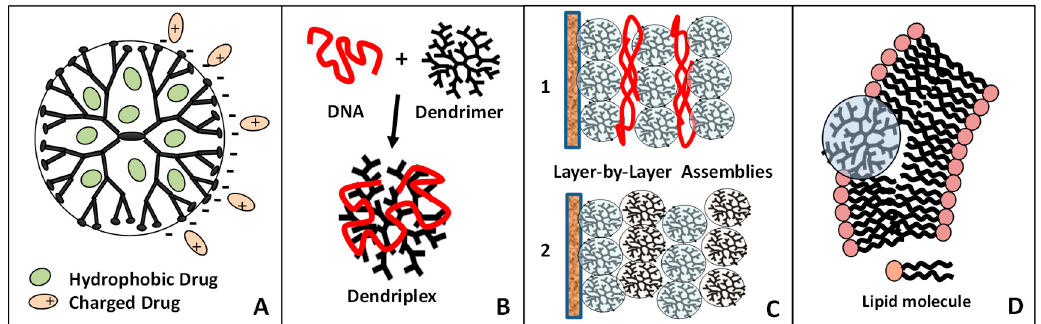
Figure 12. Inclusion and assembly of hydrophobic and hydrophilic drugs within the dendrimers structure ( A ). DNA polyelectrolyte and dendrimer interaction and formation of a dendrimer/DNA complex (called Dendriplex) ( B ). Detection support formed by dendrimer layer-by-layer (LbL) nano-assemblies ( C ). Interaction between dendrimers and lipid membrane and self-assembly of dendrimer-lipids nanostructured complexes ( D ).